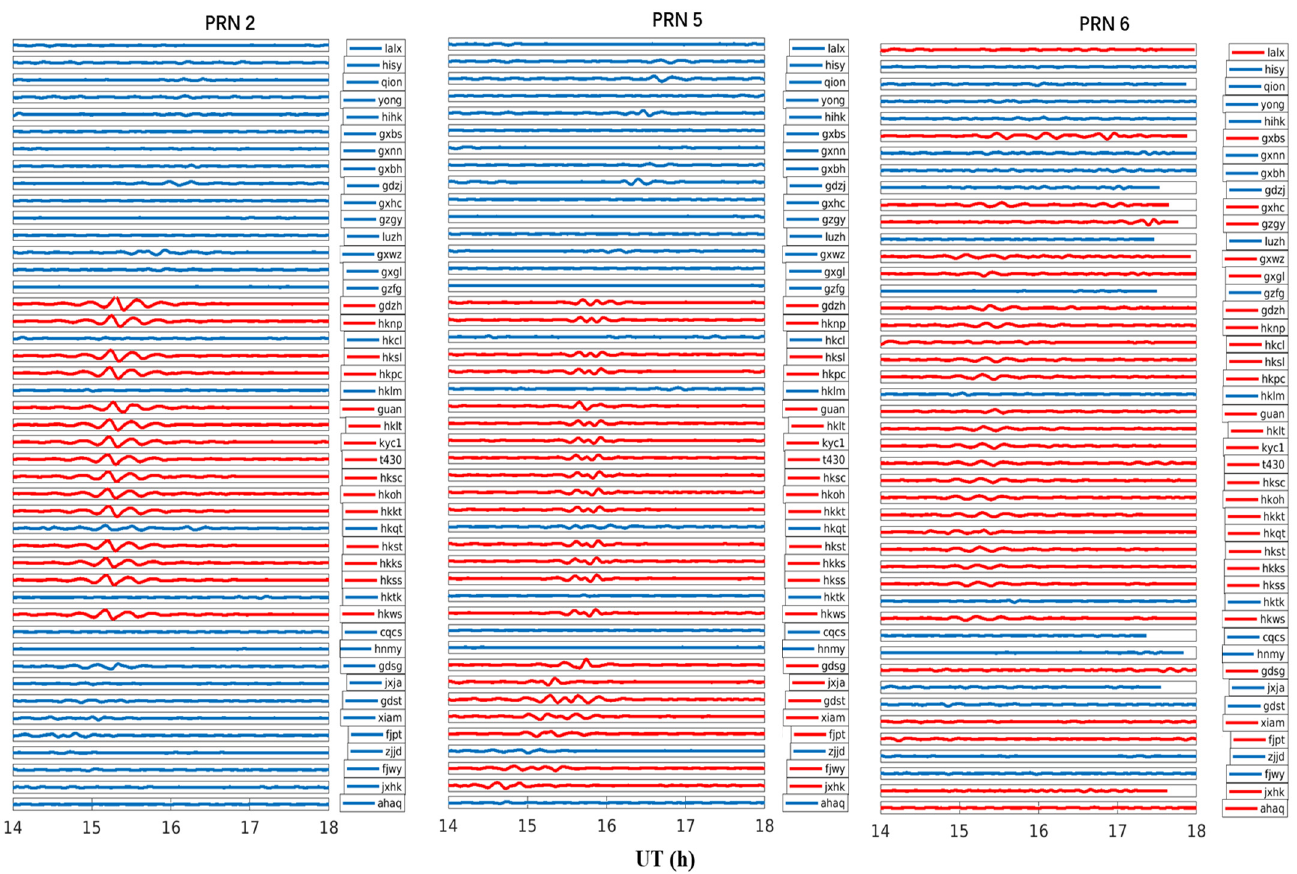
Figure 5. TEC time series for satellites 2, 5, and 6 on 3 April 2019. The legend shows the station names. The y-axis limits from [ − 0.8, 0.8] TECU for each column. The names of disturbed stations before and around 16 h are marked in red.